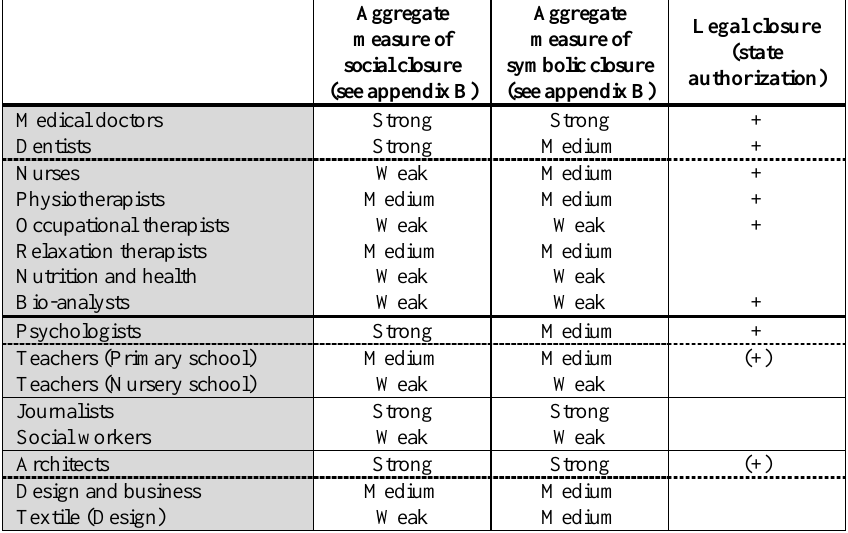
Table 5 Comparing forms of